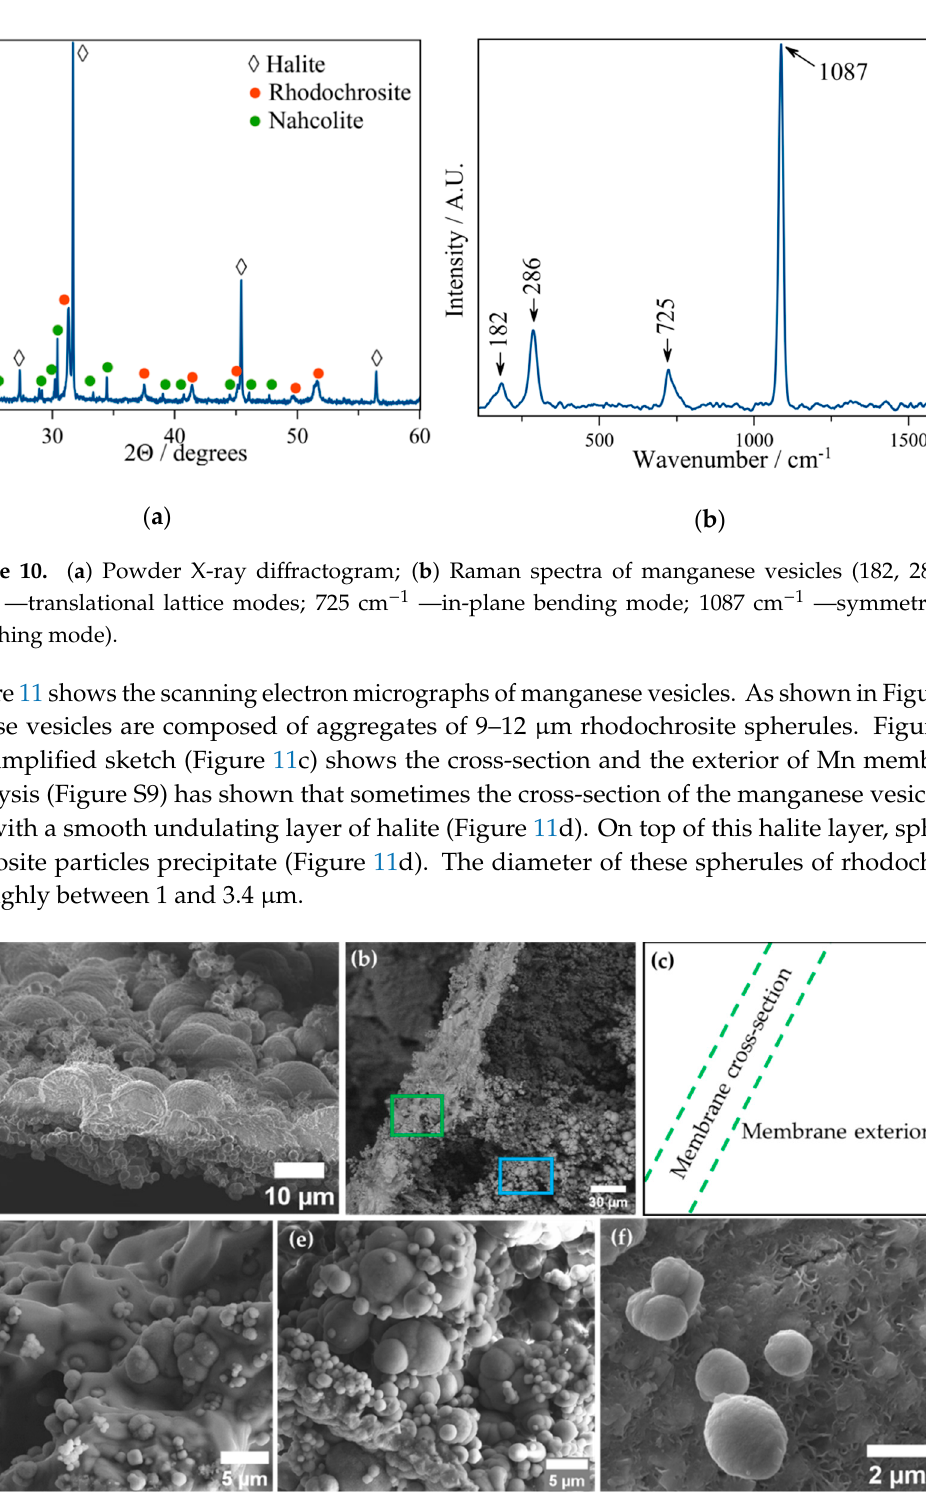
Figure 11. SEM images of manganese vesicles. ( a ) Cross-section of the membrane; ( b ) cross-section of the membrane and its exterior; ( c ) simplified sketch of panel ( b ); ( d ) closer look of the cross-section at the green rectangle in panel ( b ); ( e ) exterior of the membrane at the blue rectangle in panel ( b ); ( f ) interior wall of the membrane.